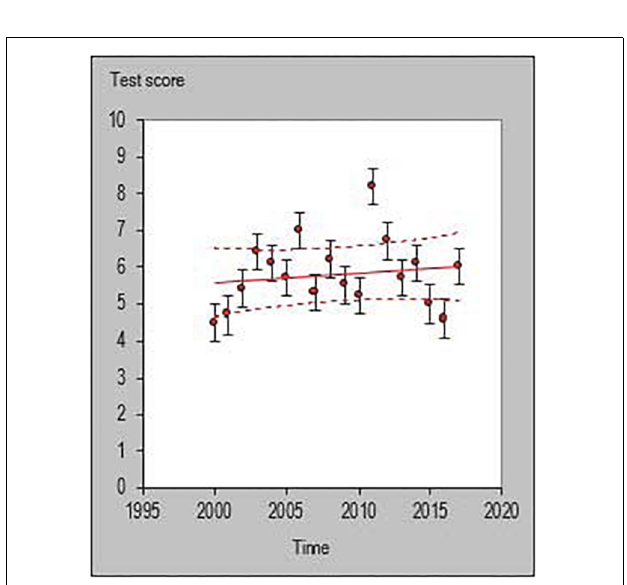
FIGURE 2 | Individual trend of one participant for average rebounds per season normalized by minute.